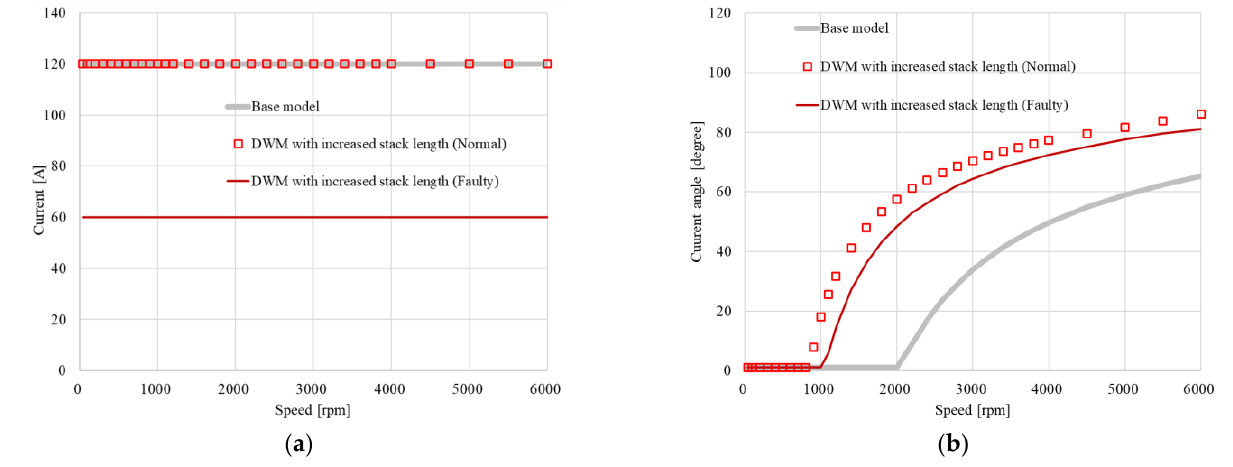
Figure 8. Comparison of peak current and current angle characteristics between the base model and the DWM with an increased stack length: ( a ) Current; ( b ) Current angle. the DWM with an increased stack length: ( a ) Current; ( b ) Current angle.